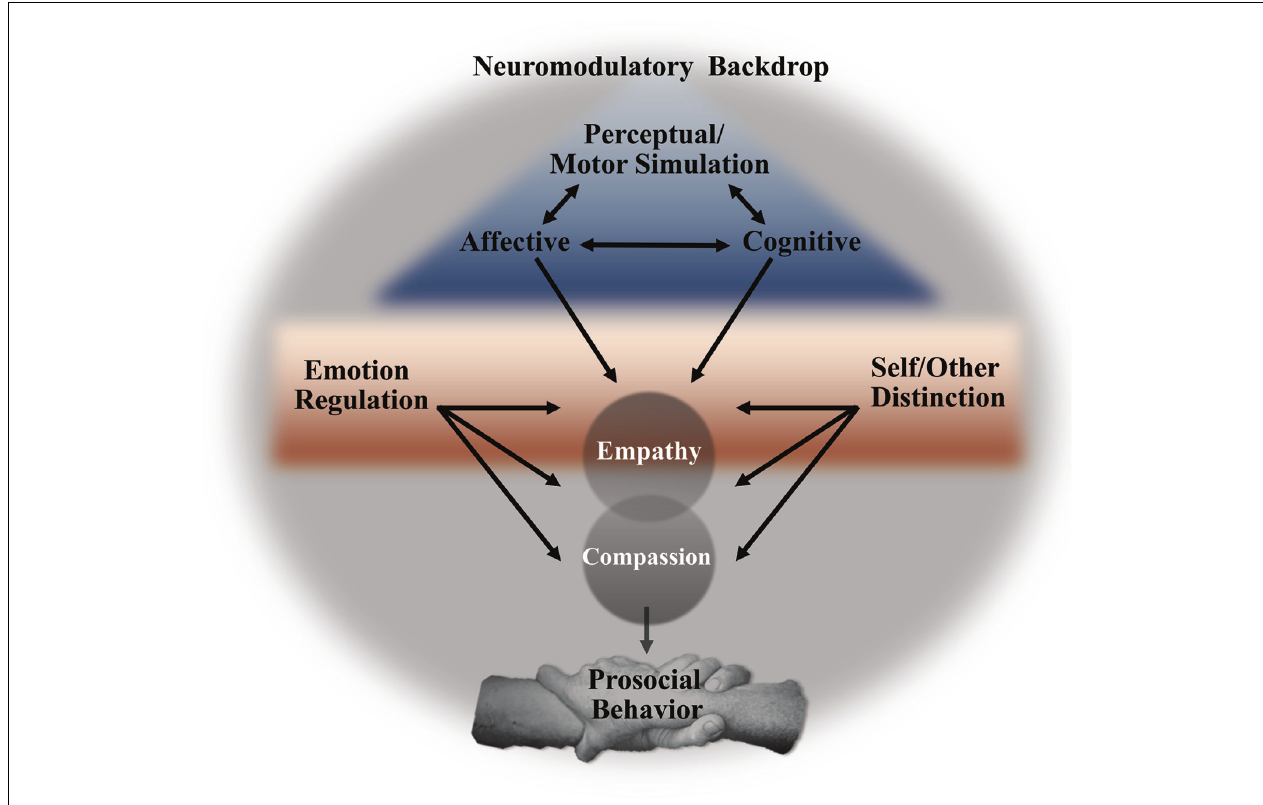
FIGURE 1 | Proposed model linking core neural processes, active amidst a neuromodulatory backdrop, leading to empathy, compassion, and prosocial